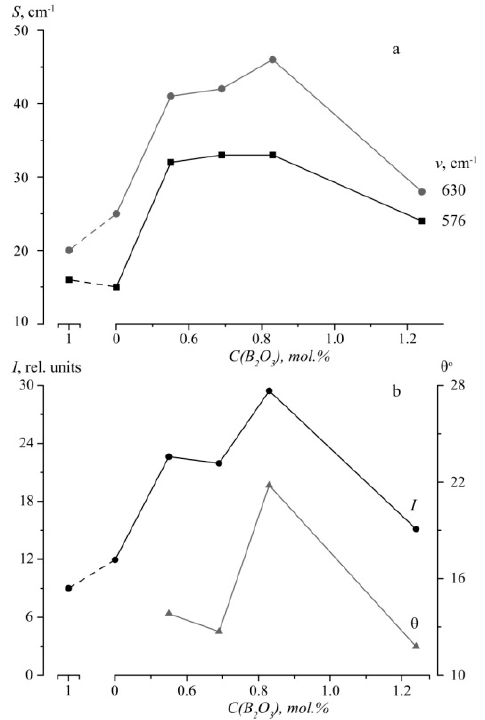
Figure 6. Concentration dependences of ( a ) width (S), ( b ) intensity (I), and PILS opening angle ( θ ) of 576 and 630 cm − 1 bands of SLN, CLN and LiNbO 3 :B (0.55–1.24 mol%) crystals. Figure ( a ) is reproduced with the permission of Pleiades Publishing from the paper N. V. Sidorov et. al ., Techn. March 2021); Figure ( b ) is reproduced with the permission of Pleiades Publishing from the paper